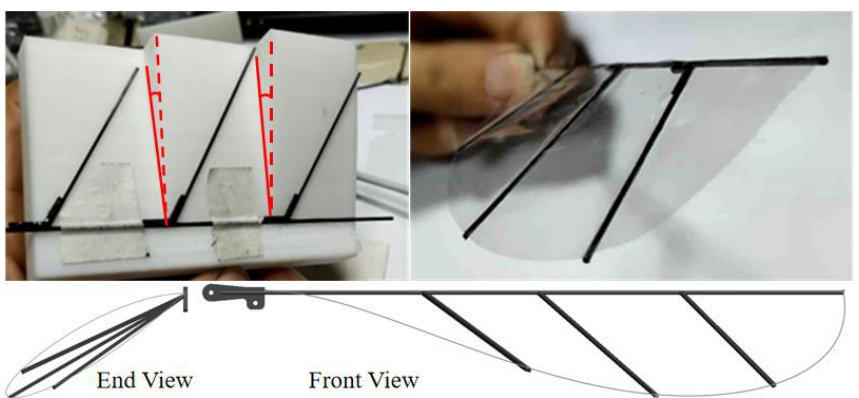
Figure 6. The flexible torsional wing and its processing methods.